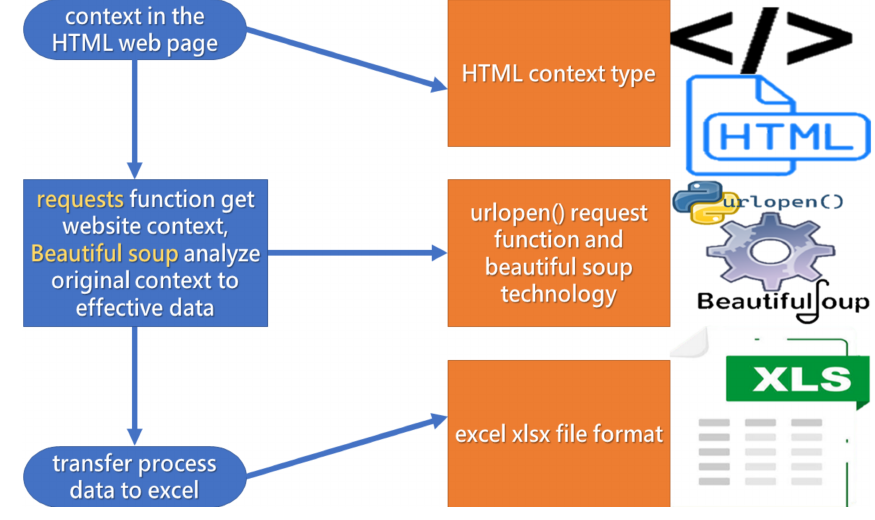
Figure 4. Web scraping scheme.